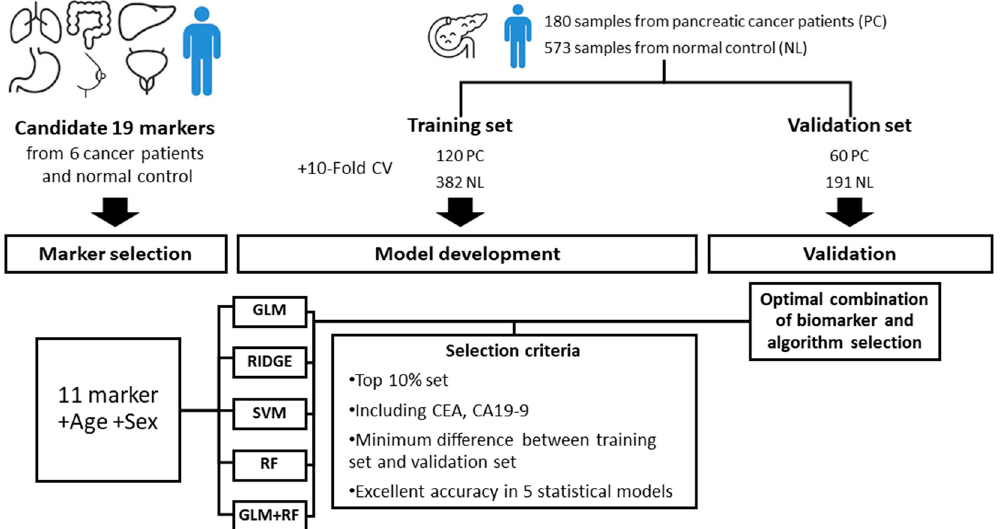
Figure 1. Study schematic flow chart . The marker panels used in the model generation consist of 11 candidate biomarkers and 2047 combinations. After combining age and gender variables to each panel, the combination is applied to the five classification algorithms. Selection criteria for optimal biomarker combinations are as follows; (1) the top 10% out of the 2047 sets, (2) sets containing CEA and CA19-9, (3) minimal difference between the training set and validation set, (4) excellent performance independent of the linear and non-linear methods.